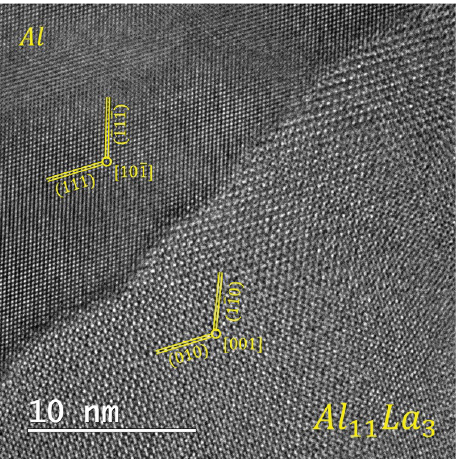
Figure 3. HRTEM image of as-cast Al–10% La alloy microstructure.